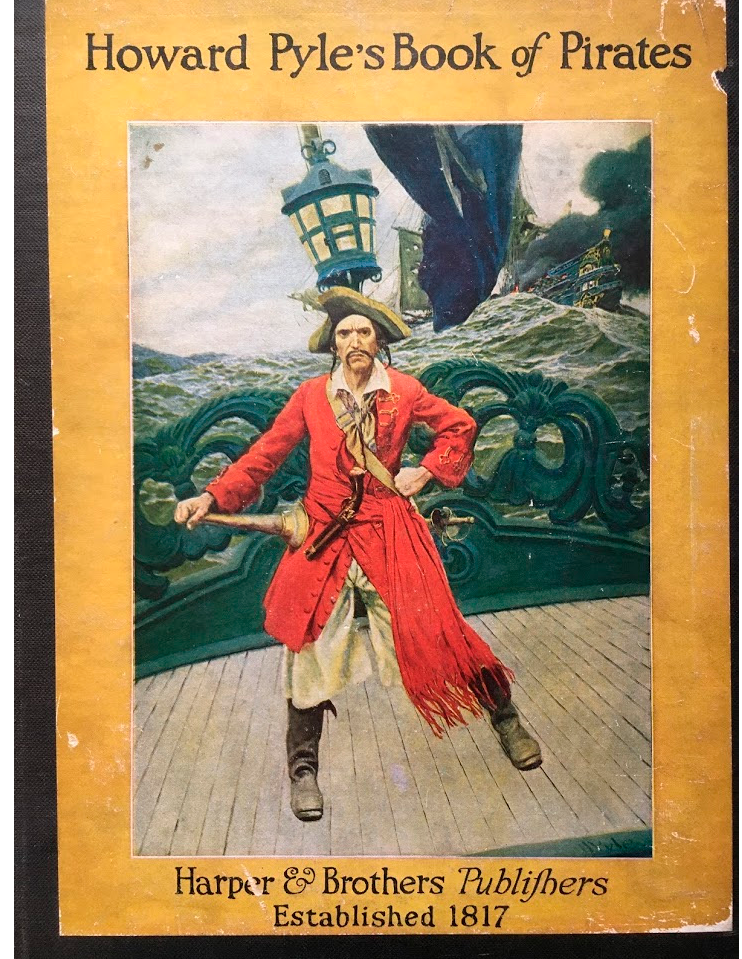
Figure 1. Cover for Howard Pyle’s Book of Pirates (Pyle 1921). From Richard J. Hill’s collection.